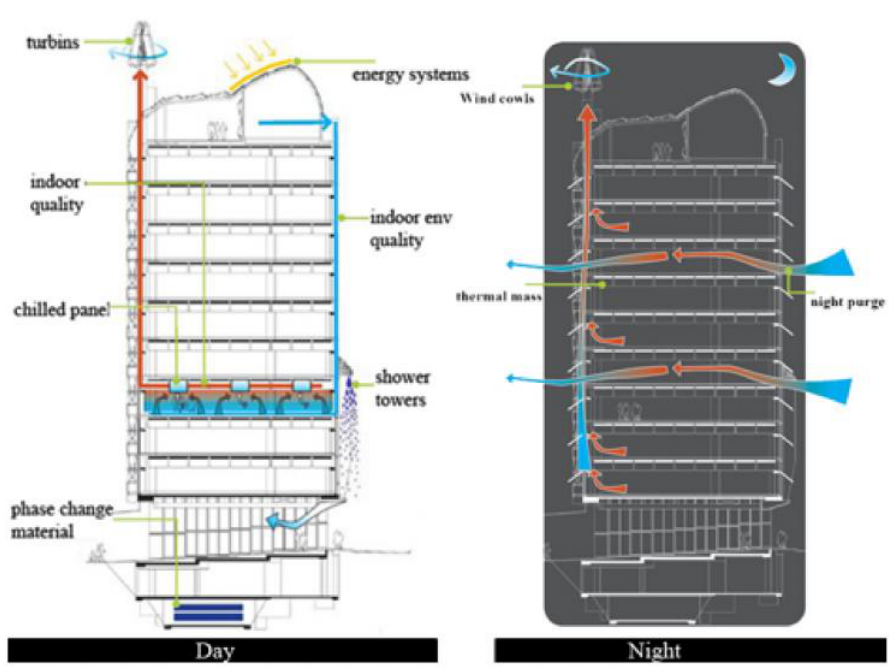
Fig. 2: daytime and nighttime functional process of CH2 building in summer, the author based on (Tan, 2007)